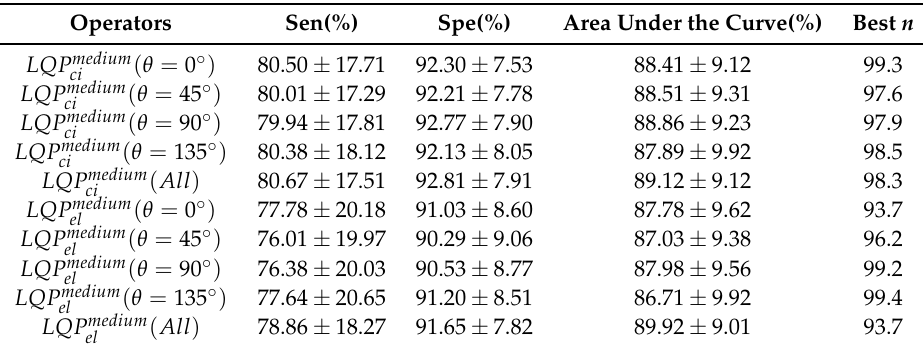
Table 4. Overall quantitative results for MIAS [18] database using circle and ellipse topologies. The parameters R and P are based on the values in Table 3.